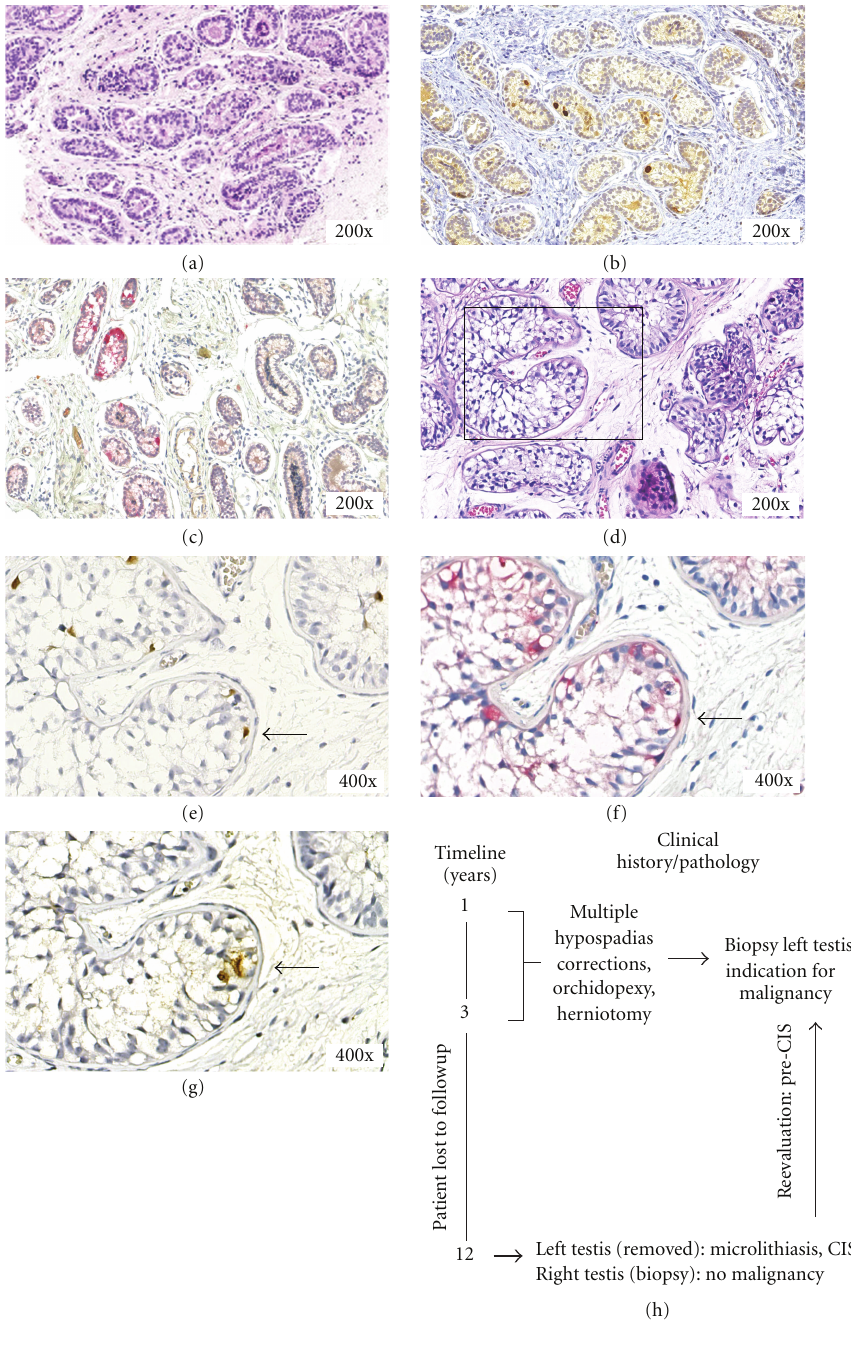
Figure 3: Immunohistochemical staining of the carcinoma in situ lesion of patient 3 at three and twelve years of age. (a) Representative hematoxylin and eosin staining. Positive staining for (b) OCT3/4 (brown), (c) TSPY (red) of the germ cells present in the CIS. (a–c) Biopsy tissue at 3 years of age. (d) Representative hematoxylin and eosin staining. Positive staining for (e) OCT3/4 (brown), (f) TSPY (red), and (g) SCF (brown) of the CIS cells. (d–g) Gonadal tissue at 12 years of age. (e–g) Region indicated with a square in (d) is shown. Note the expression of OCT3/4, TSPY, and SCF in the CIS cell indicated by the arrow. Magnification 200x and 400x for all. Slides (b)–(g) are counterstained with hematoxylin. (h) Timeline showing the clinical history, histology, and actions